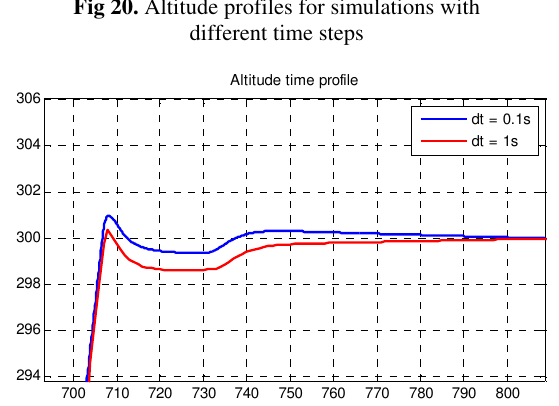
Fig 21. Altitude profiles at the moment of reaching the cruise altitude of 300 m